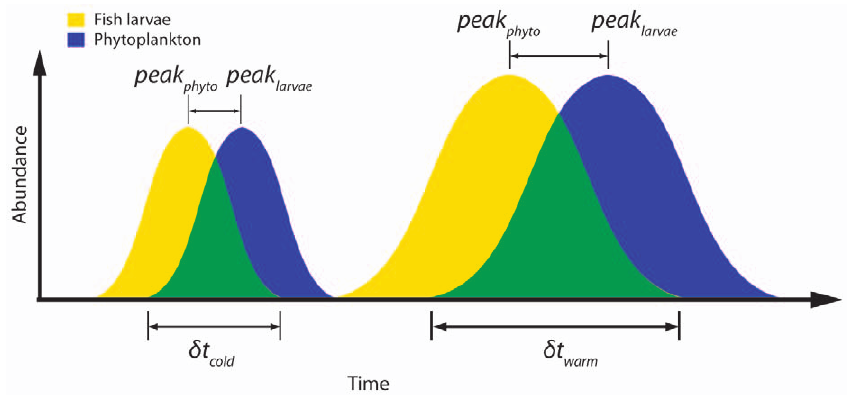
Figure 6. Conceptual diagram of the temporal relationship between larval fish abundance (yellow) and phytoplankton biomass (blue). During the time period when these overlap (green), the larvae will have adequate food conditions and therefore enhanced survival probability. In years when the water temperature is warmer, this time-period ( duration ) is longer compared to in colder years. In addition, during years of high prey abundance (right), the consequences of the lag in time between the occurrence of peak food and peak larval production is less important. Increase in primary production in warmer years enables higher total production over a longer time window because production starts earlier in spring. Based on Figure 1 in